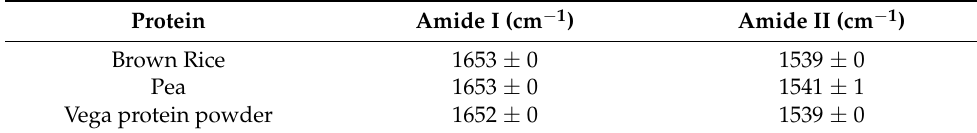
Figure 6. Amide I and amide II regions, comparing Vega protein powder to protein standards. MIR spectra of plant-based protein product ( = Vega) and protein standards ( = Brown Rice and = Pea, observing ( a ) the amide I spectral region (1700–1600 cm − 1 ), and ( b ) the amide II spectral region (1580–1510 cm − 1 ). Table 3. IR data comparing brown rice and pea protein standards to Vega protein powder.